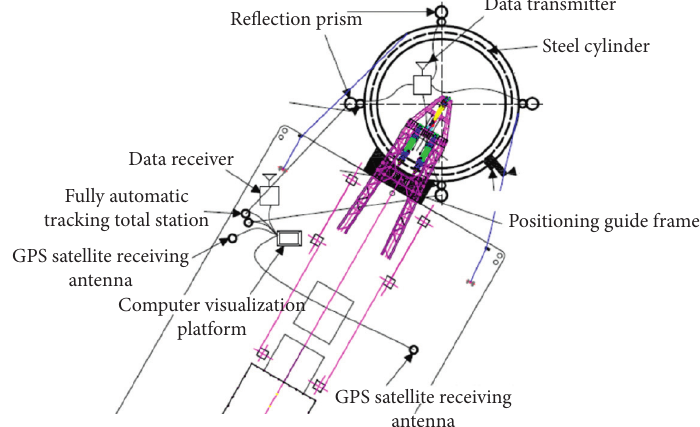
Figure 20: Monitoring and location system structure.